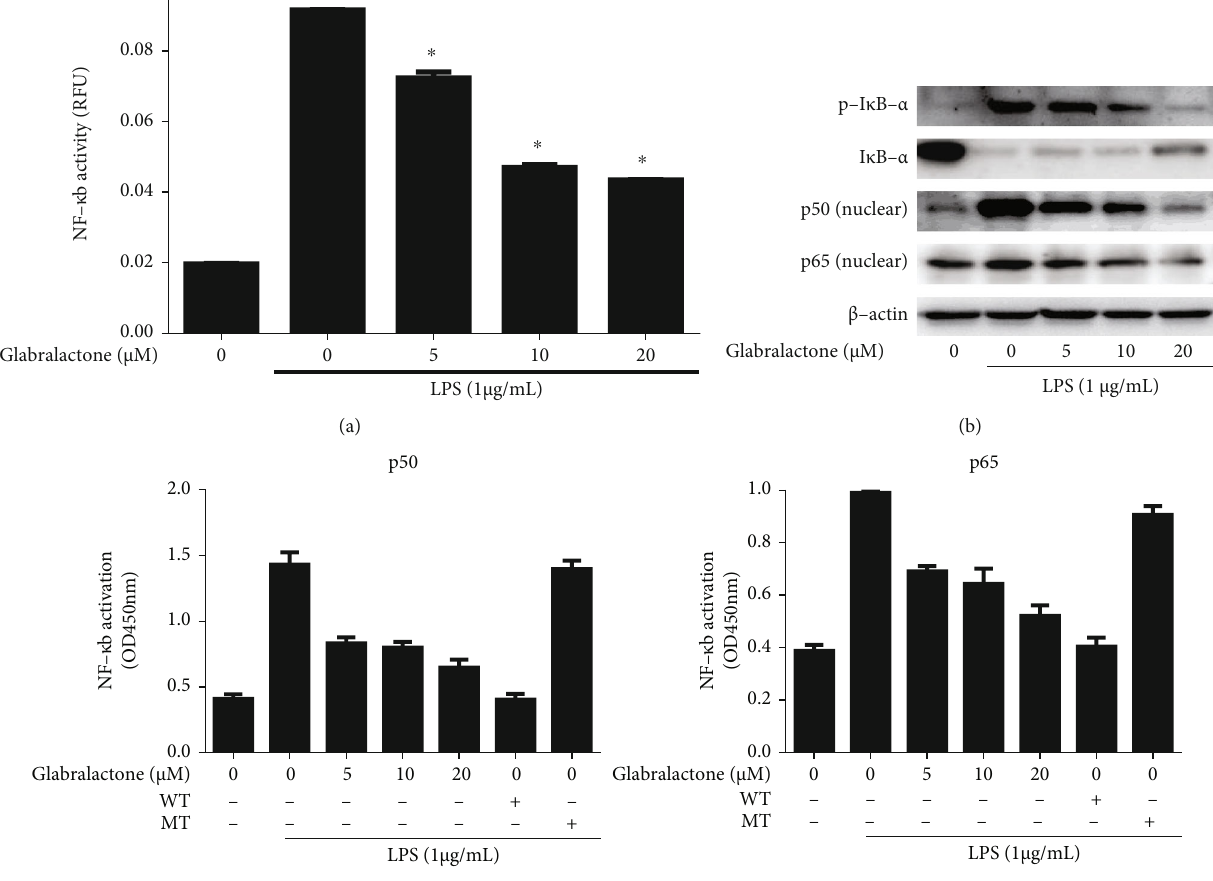
Figure 3: E ff ect of glabralactone on LPS-stimulated NF- κ B transcriptional activity. (a) SEAP-RAW cells were stimulated with LPS (1 μ g/mL). After 16 h of glabralactone treatment, the supernatants were analyzed. The values are expressed as the mean ± SD . ∗ p < 0 : 05 was considered statistically signi fi cant. (b) E ff ects of glabralactone on the degradation of I κ B- α and on the expression of NF- κ B subunits in the nucleus. RAW 264.7 cells were pretreated with glabralactone for 30min and stimulated with LPS for 30 min. The extracted proteins were analyzed by Western blotting. Data are representative of three separate experiments. β -Actin was used as an internal standard. (c) E ff ects of glabralactone on the LPS-stimulated NF- κ B DNA-binding activity. Cells were stimulated with LPS (1 μ g/mL) for 1.5 h in the presence of glabralactone, and the isolated nuclear extracts were analyzed for NF- κ B DNA-binding activity. The values are expressed as the means ± SD . (left for p50, right for p65). Glabralactone was dissolved in 100% DMSO, and the fi nal concentration of DMSO was adjusted to